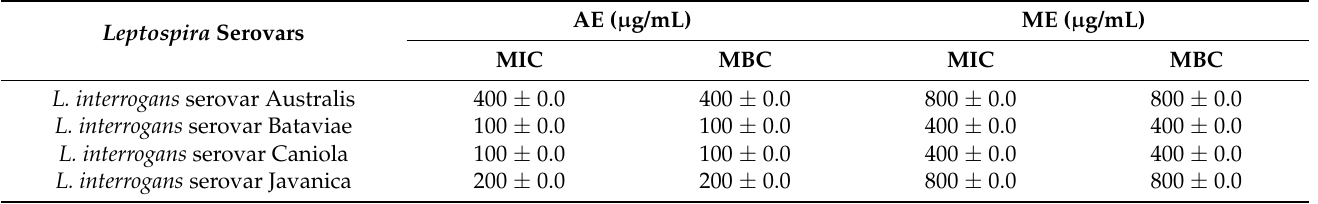
Table 1. MIC and MBC values (mean ± SD) of P. amarus extracts on Leptospira serovars in triplicate. Leptospira Serovars